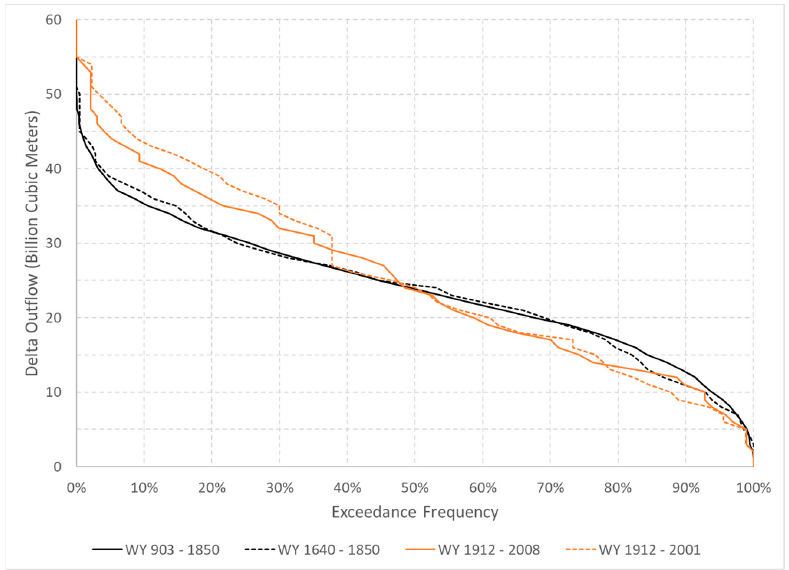
Figure 8. Reconstructed delta outflow exceedance frequency under pre-development (Model 2) and contemporary (Model 3) conditions, for the long and short record reconstructions.